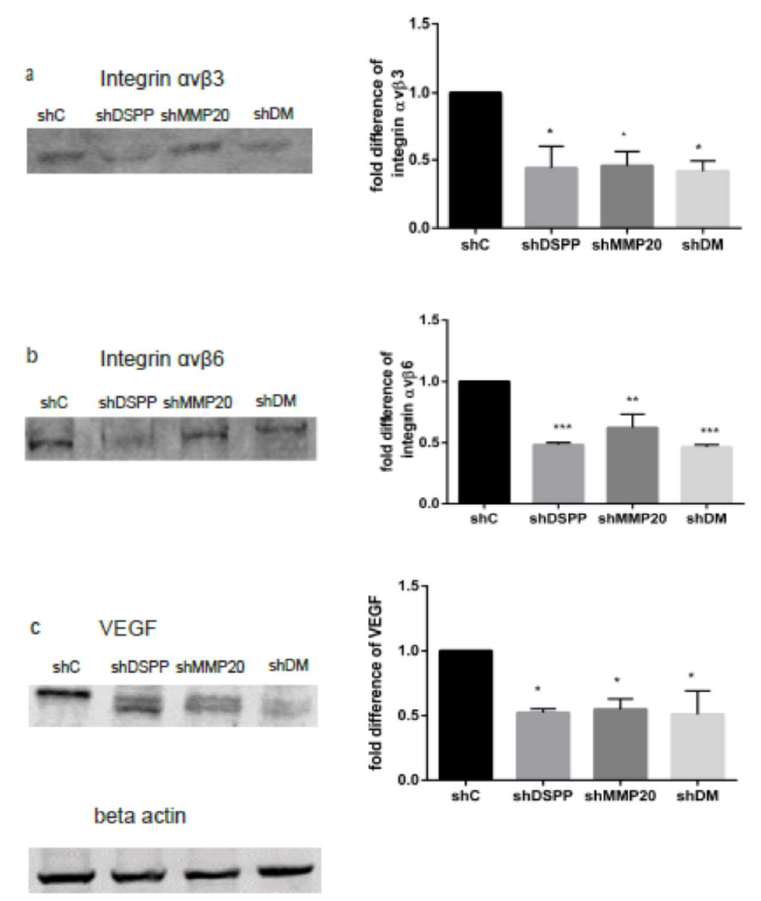
Figure 2. WB analysis of the effects of DSPP and MMP20 silencing on α v β 3, α v β 6, and VEGF levels. ( a ) Downregulation of α v β 3 in shDSPP (50%), shMMP20 (55%), and shDM (45%) were significant ( p < 0.05) when compared to the control. ( b ) Downregulation of α v β 6 in shDSPP (48%), shMMP20 (38%),